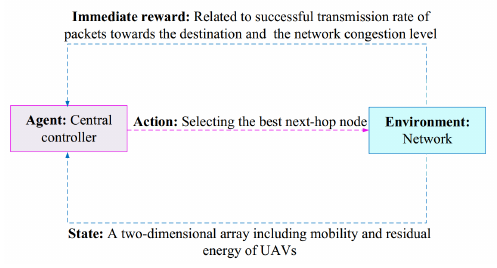
Figure 26. Learning process in DQN-VR. Table 8. The most important advantages and disadvantages of